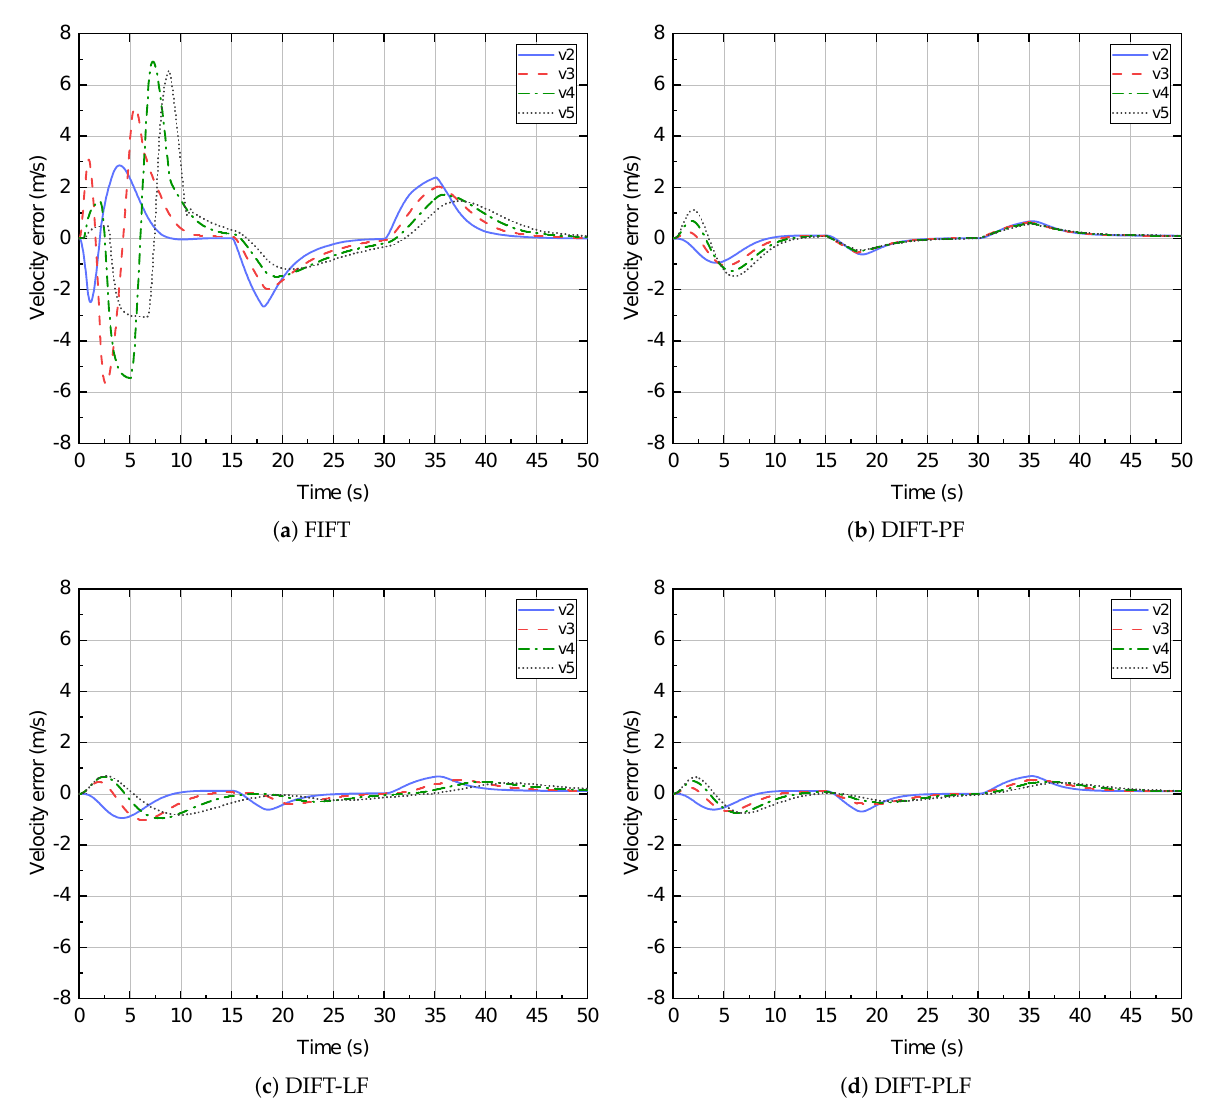
Figure 13. Velocity tracking